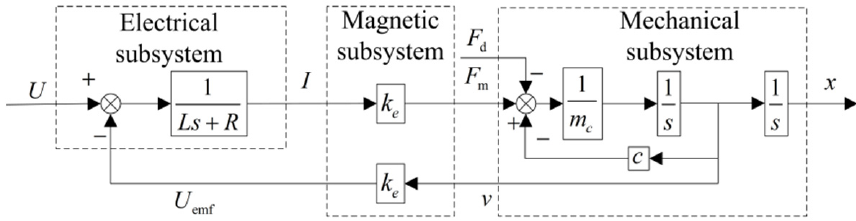
Figure 2. The structure and composition of the LEMA.